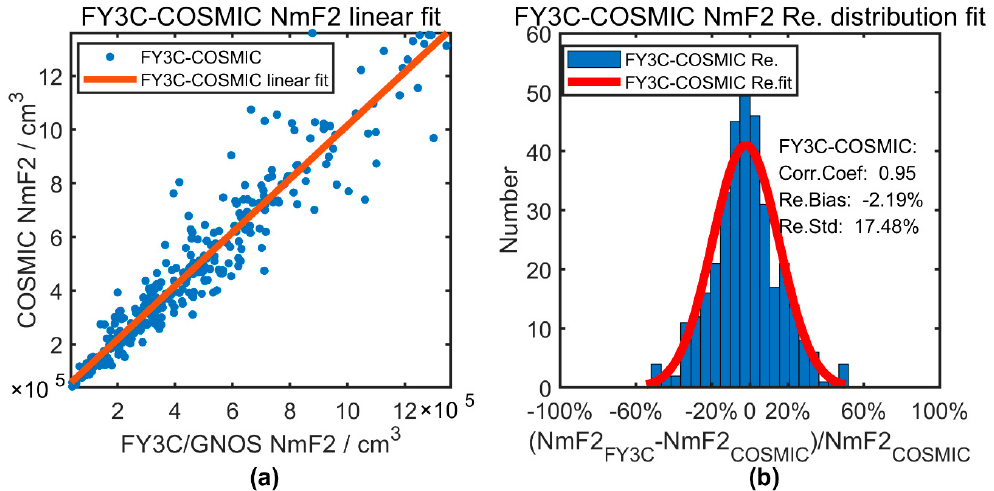
Figure 2. Linear fit and statistical error distribution of NmF2 between FengYun-3C (FY3C) / Global Navigation Satellite System occultation sounder (GNOS) and Constellation Observing System for Meteorology, Ionosphere, and Climate (COSMIC) over a whole day during 2016.035 and 2017.035: ( a ) the linear fit of NmF2 between FY3C / GNOS (horizontal axis) and COSMIC (vertical axis) over a whole day, in which the blue dots represent the matched data pairs of NmF2 and the red line depicts the linear regression fit of NmF2 data pairs; ( b ) the number (vertical axis) of NmF2 relative errors (horizontal axis) between FY3C / GNOS and COSMIC, in which the red curve represents the distribution fit of the relative errors. The correlation coe ffi cient of NmF2 data pairs, bias, and std of relative errors of matched NmF2 data pairs are also labelled in the right side of ( b